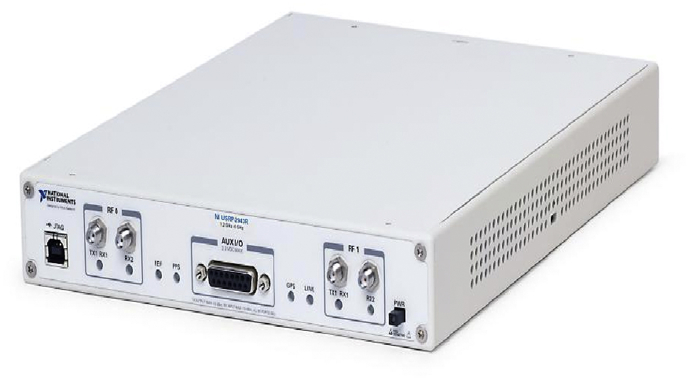
NI USRP-2943R RF receiver [4].